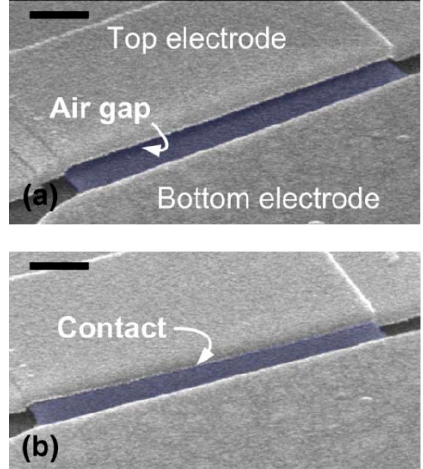
Figure 5. SEM images of a graphene cantilever-type switch with a local top actuation electrode ( a ) before and ( b ) after the switching operation. The initial air gap g 0 between the graphene and the top electrode is about 140 nm. The graphene cantilever is artificially colored in light blue. The scale bars are 500 nm.